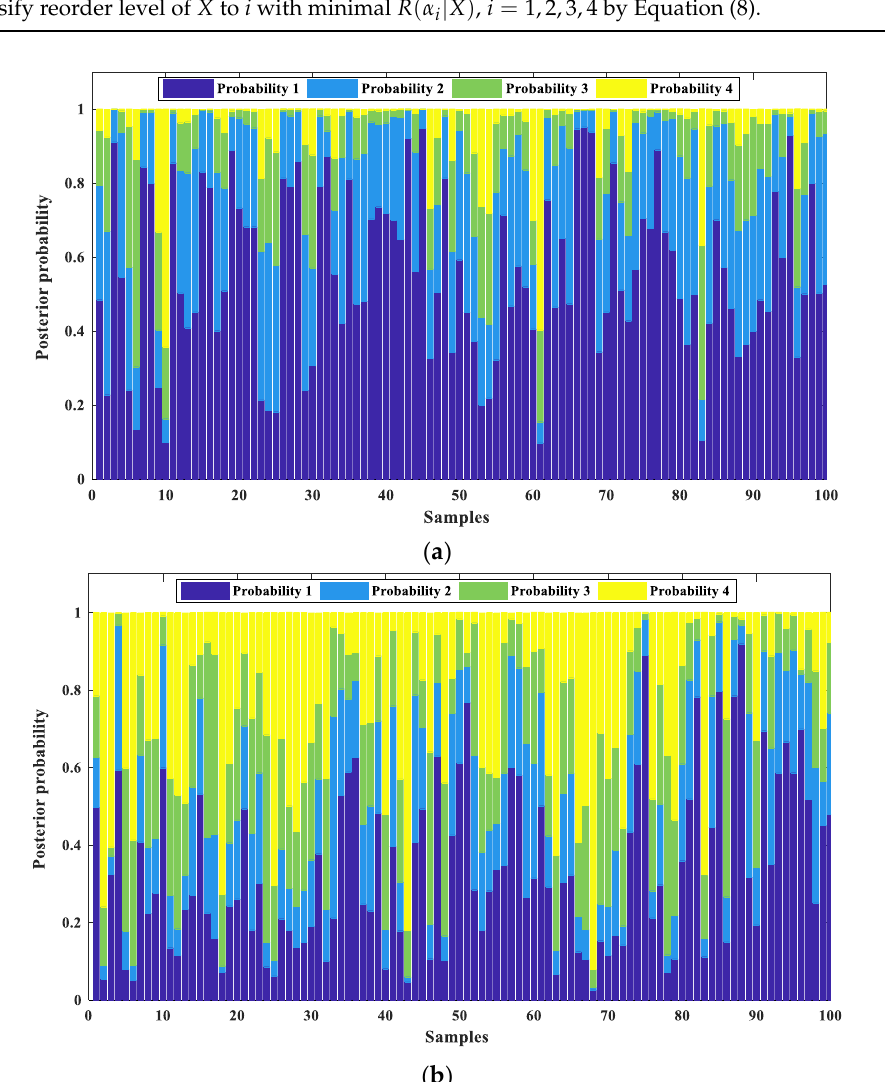
Figure 7. Posterior probabilities for 100 randomly selected samples. ( a ) Posterior probabilities for 100 randomly selected samples with observed Re l = 2. ( b ) Posterior probabilities for 100 randomly selected samples with observed Re l = 4.